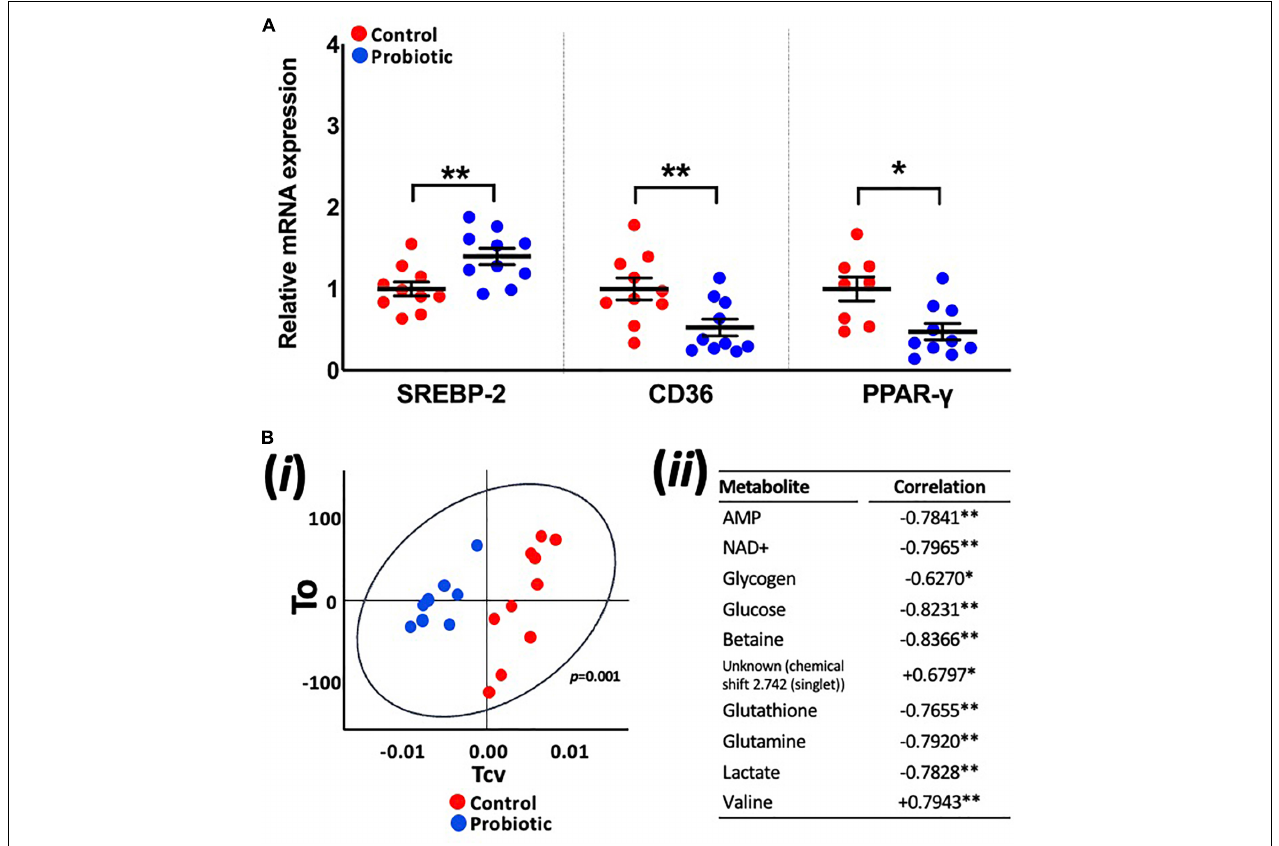
FIGURE 4 | Expression levels of lipogenic genes and the metabolite profile of the liver. (A) The relative mRNA expression levels of SREBP-2, CD36, and PPAR- γ in the liver of 3xTg-AD mice and (Bi) principle component analysis (PCA) of liver metabolites in the Control and Probiotic groups and (Bii) correlation of individual liver metabolites in the Probiotic group (in relation to the Control group; negative values indicate higher correlation in Control group whereas positive values indicate higher correlation in the Probiotic group). Data are expressed as mean ± SEM of at least eight mice per group. Values of p were determined using unpaired t -test (A) or using two-tailed t -test (B) . * p < 0.05 or ** p < 0.01. SREBP-2, sterol-regulatory element-binding protein-2; CD36, cluster of differentiation 36; PPAR- γ , peroxisome proliferator-activated